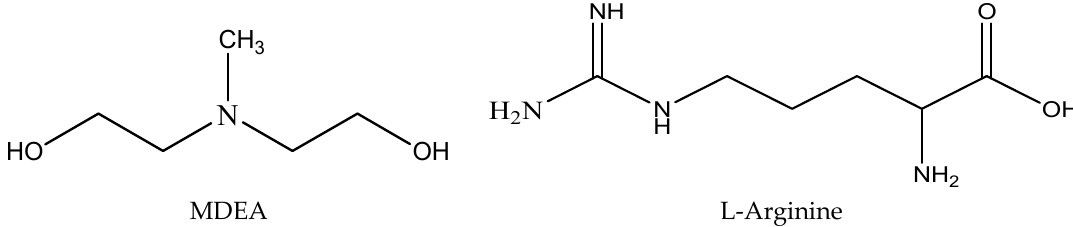
Figure 1. Molecular Structure of MDEA (N-methyldiethanolamine) and